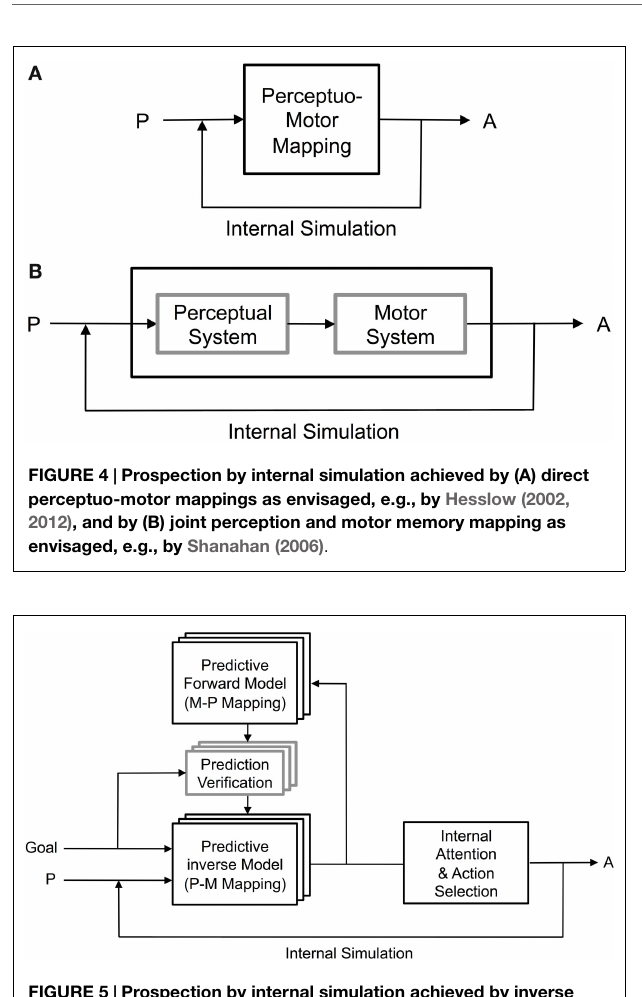
FIGURE 5 | Prospection by internal simulation achieved by inverse models mapping from current state and goal state to predicted motor command, then validating this by mapping from predicted motor command to predicted perceptual outcome, as envisaged by Demiris and Khadhouri (2006) and Demiris et al. (2014) . Many mappings are possible so an internal attention winner-take-all competition selects the most appropriate action to